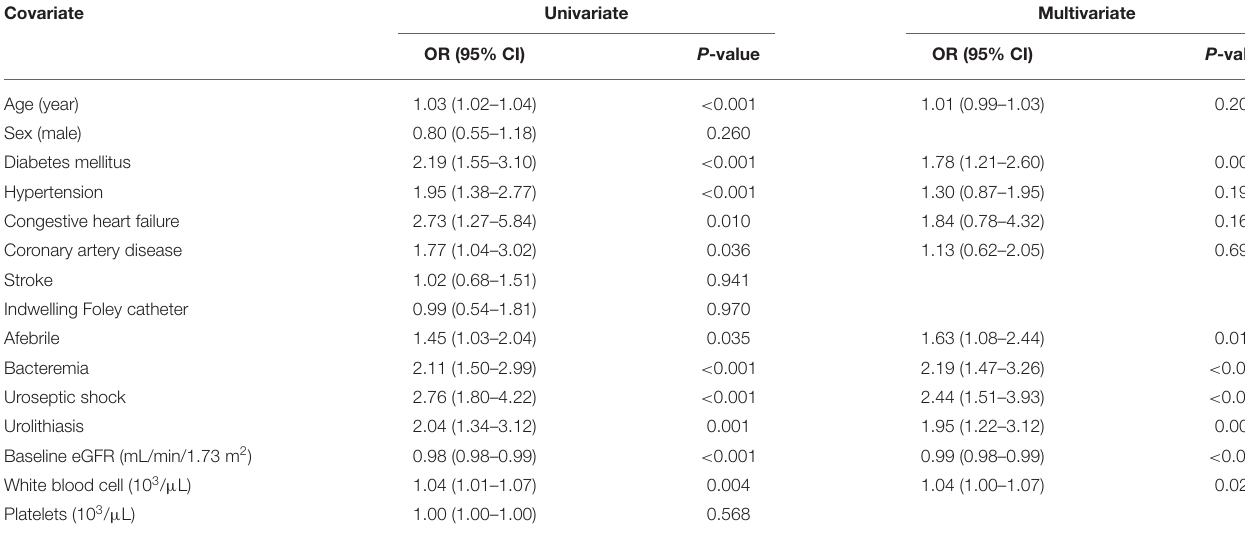
TABLE 3 | Univariate and multivariate logistic regression analyses of factors related to acute kidney injury in patients with urinary tract infection. Covariate